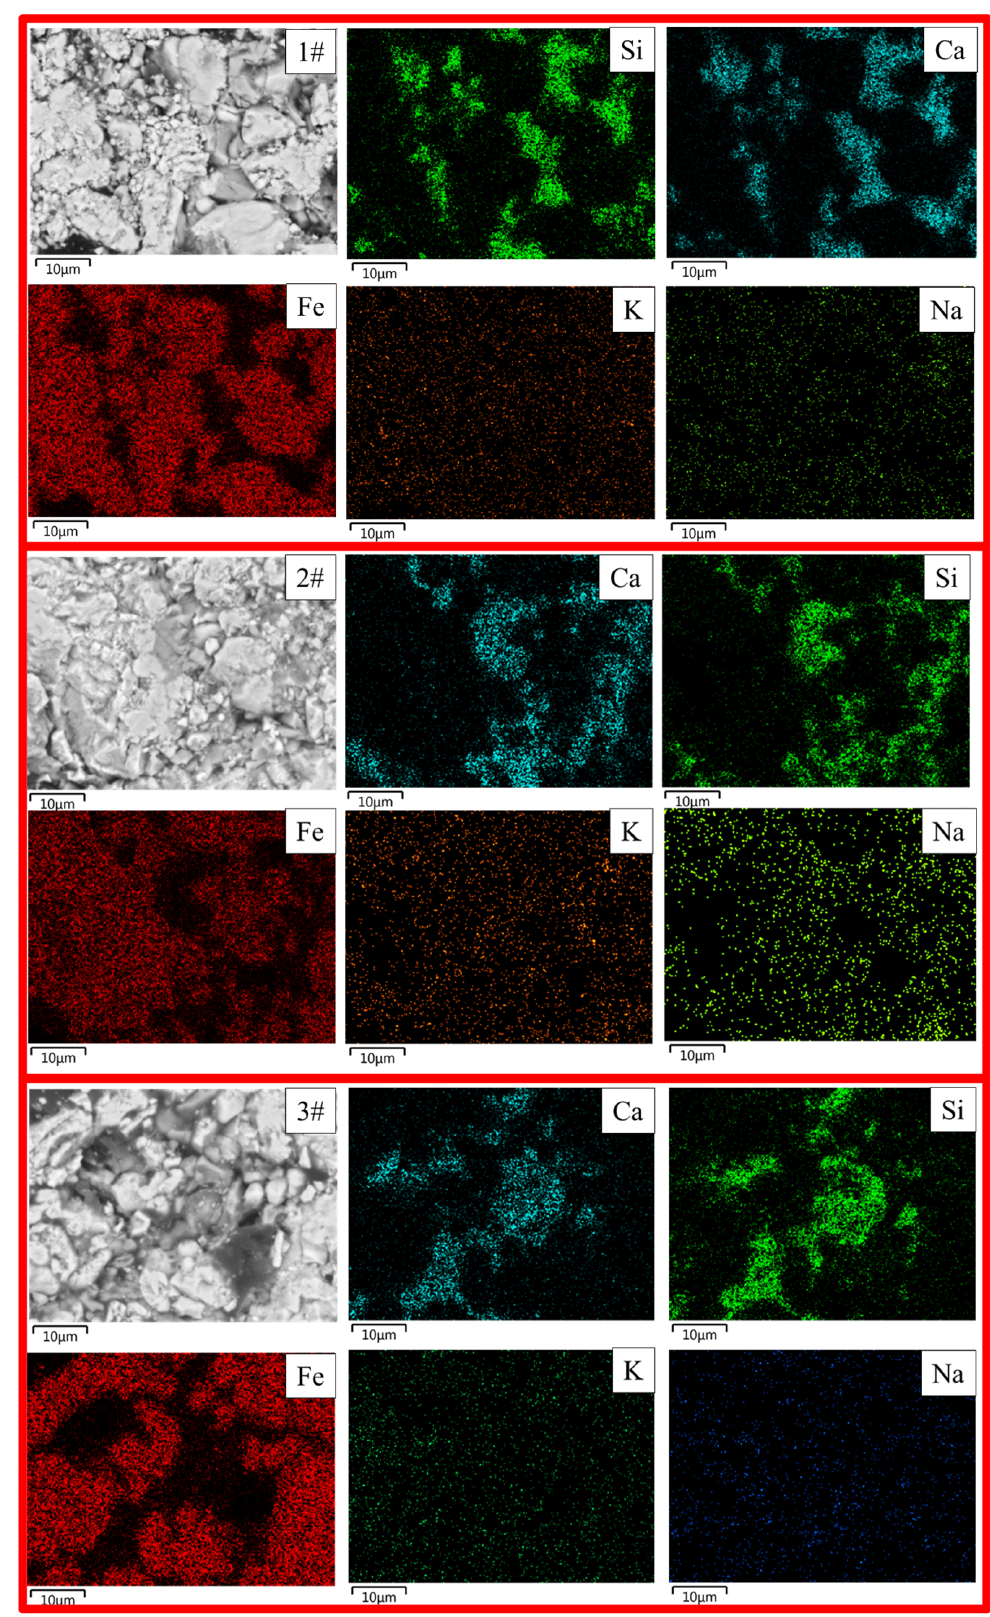
Figure 12. Energy-dispersive spectrum of the first reduction stage of iron oxides with different ba- sicities.